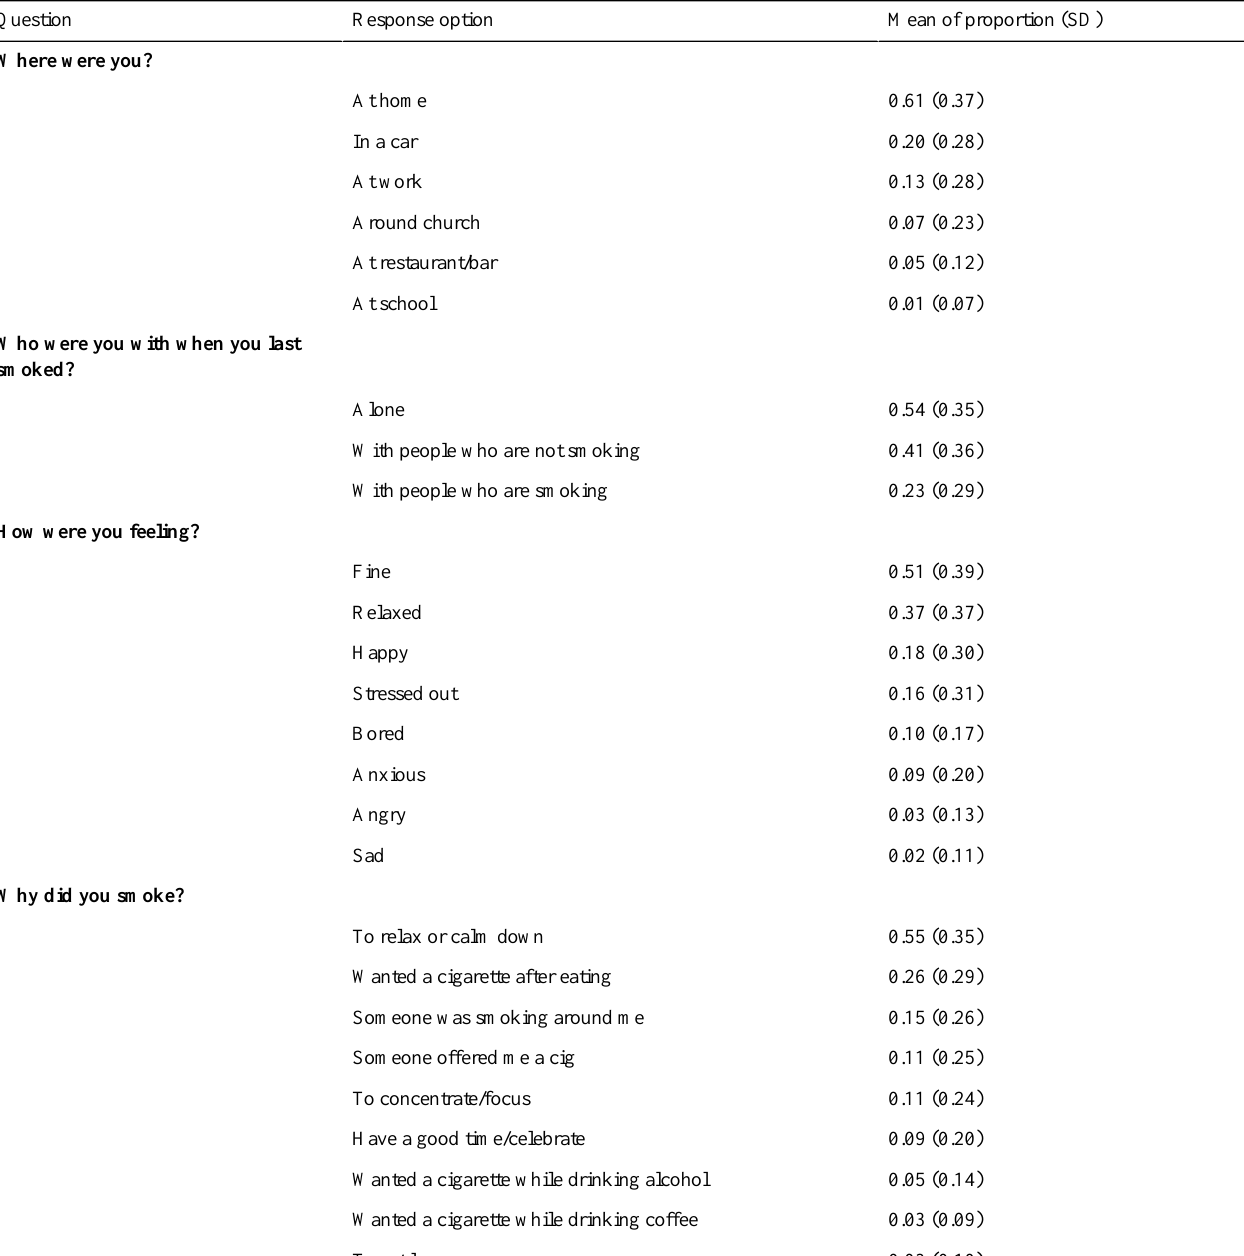
Mean of proportion (SD)Response optionQuestion